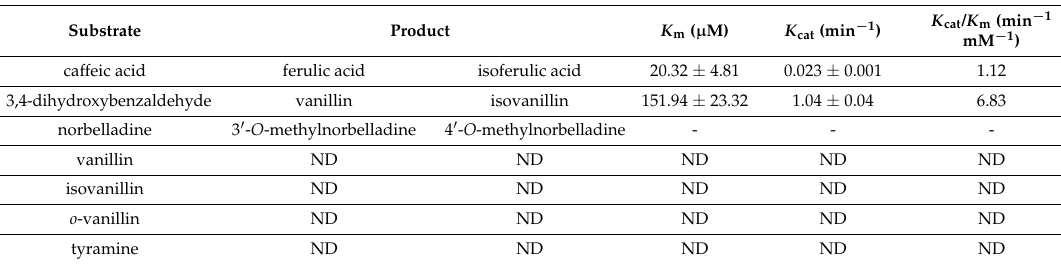
Table 1. Substrate specificity of LaOMT1.